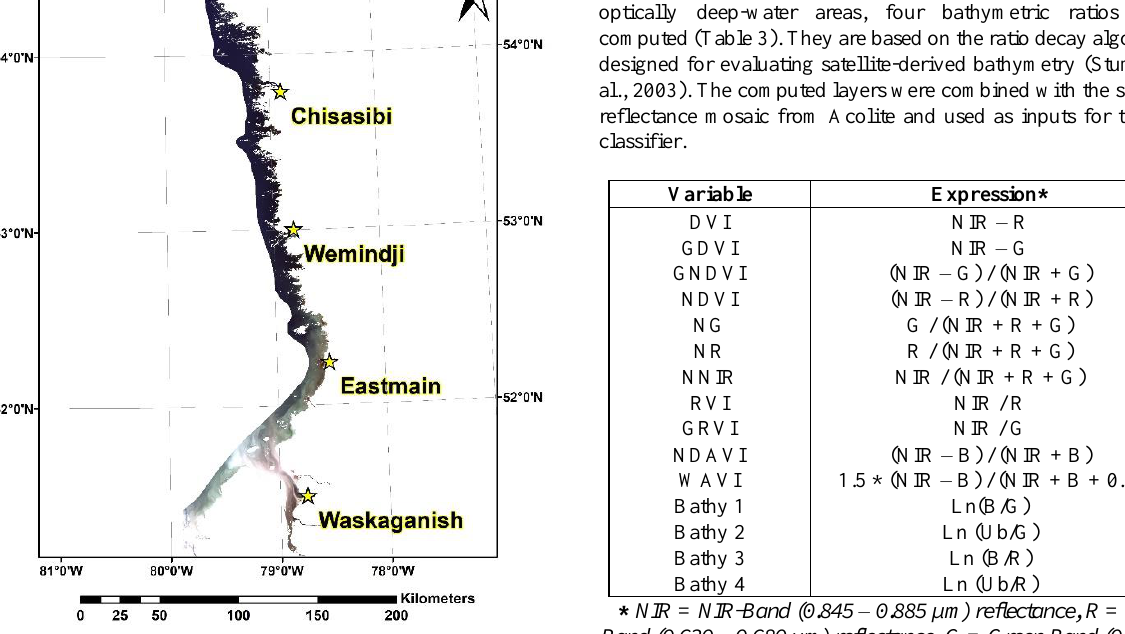
Figure 2. RGB composite for the mosaic created using Acolite with the images acquired over James Bay on September 16,